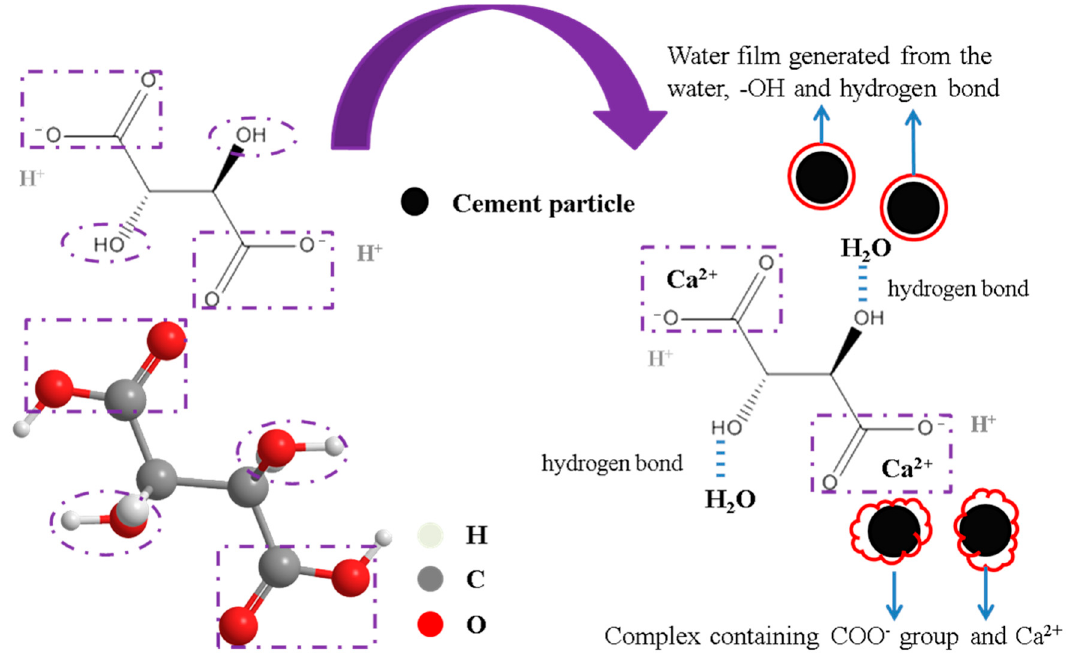
Figure 7. The retardation and rheology mechanism of TA to the 3D printing sulphoaluminate cement (3DP SAC) paste.